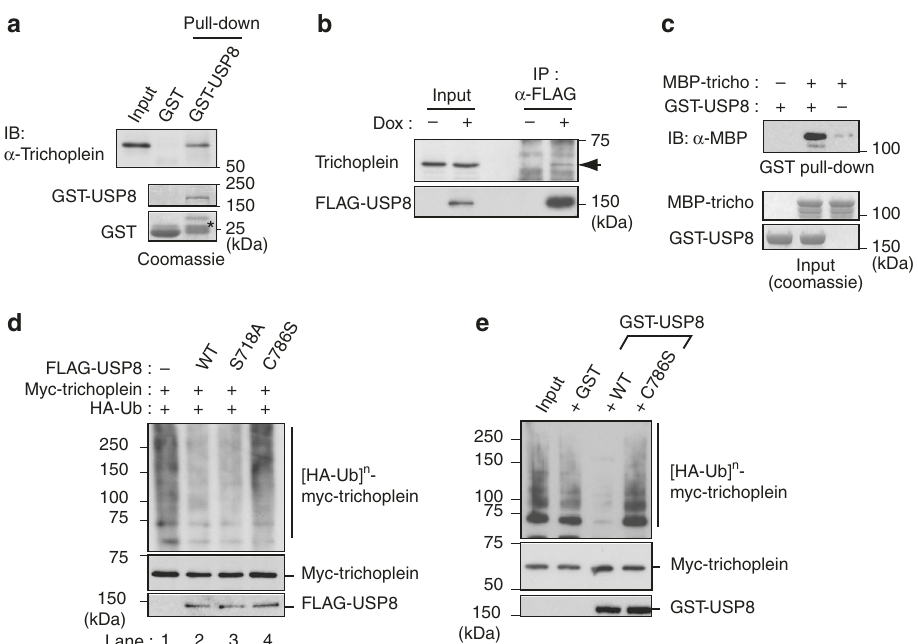
Fig. 5 USP8 binds and deubiquitinates trichoplein. a Bacterially puri fi ed GST or GST-USP8 were incubated with RPE1 cell lysates, and then af fi nity puri fi ed with glutathione-sepharose. The samples were analyzed by immunoblotting with anti-trichoplein and by coomassie staining. Asterisk indicates fragmented GST-USP8. b Endogenous trichoplein (indicated by arrow) was co-immunoprecipitated with anti-FLAG antibody form TetOn-RPE1 FLAG-USP8 WT cells that were treated with, but not without, doxycycline (Dox: 100 ng ml − 1 ). c GST-USP8 was incubated with MBP-trichoplein in vitro, and then af fi nity puri fi ed with glutathione-sepharose. d Myc-trichoplein and HA-ubiquitin were co-transfected with or without FLAG-USP8 (WT, S718A, or C786S) in HEK293T cells. Six hours after treatment with 10 μ M MG132, anti-Myc immunoprecipitates were analyzed by immunoblotting with anti-HA and anti-Myc. Amounts of FLAG-USP8 proteins were analyzed in cell lysates. e Polyubiquitinated Myc-trichoplein ([HA-Ub] n -Myc-trichoplein) was immunoprecipitated from HEK293T cells transfected with Myc-trichoplein and HA-ubiquitin (input), as described in d , and then incubated with GST or GST-USP8 (WT or C786S) for 1 h at 37